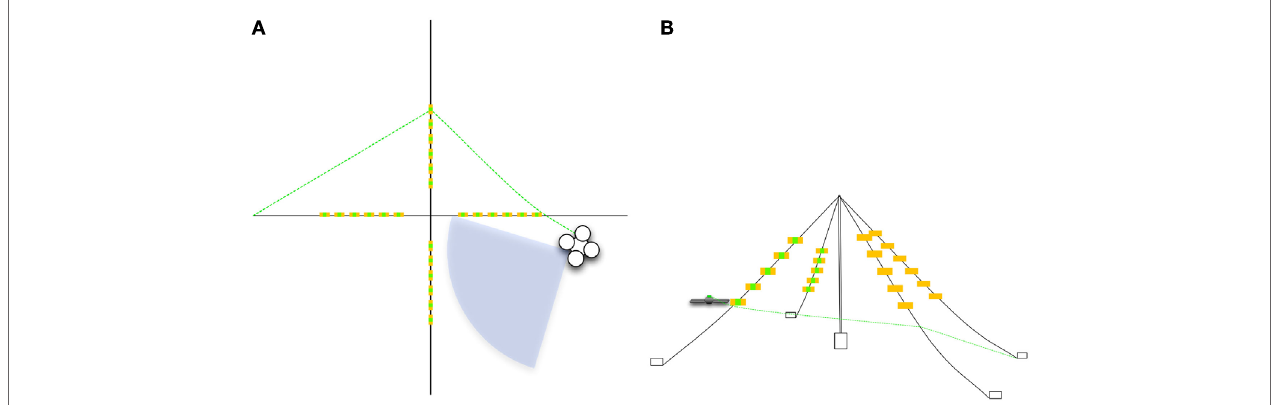
FigUre 2 | (a) The quad-rotor hovers clock-wise around a pole that is suspended by four lines. It tightens a rope (green, dashed) along the suspension lines. (B) A schematic side-view extracted from a photograph, highlighting the orientation of the markers pinned to the suspension lines. Both figures © 2014 IEEE. Reprinted, with permission, from von Mammen et al.